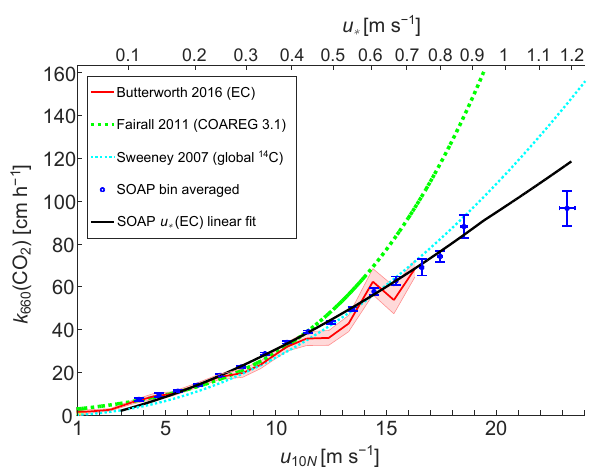
Figure 9. CO 2 gas transfer velocity normalised to Sc = 660 as a function of normalised wind speed u 10N , which was calculated from the directly measured u ∗ using the COARE 3.5 drag coeffi- cient. The data are bin averaged over 1ms − 1 wind-speed bins (dark blue) (the width of the last two bins was increased to 3ms − 1 in or- der to account for the scarcity of the data at high wind speeds). The error bars indicate the standard deviations. Equation (10) is shown as a black line. Parameterisations from Sweeney et al. (2007) and Fairall et al. (2011) are shown as dashed lines in green and cyan, respectively. Also shown are 1ms − 1 wind-speed bin median val- ues (and standard deviations) observed by Butterworth and Miller (2016b) with EC in the high-latitude Southern Ocean (red).